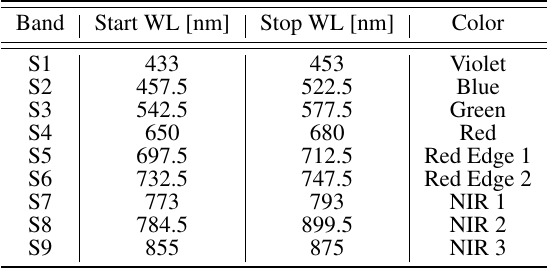
Table 1. Wavelength (WL) intervals of MAIA S-2 bands.